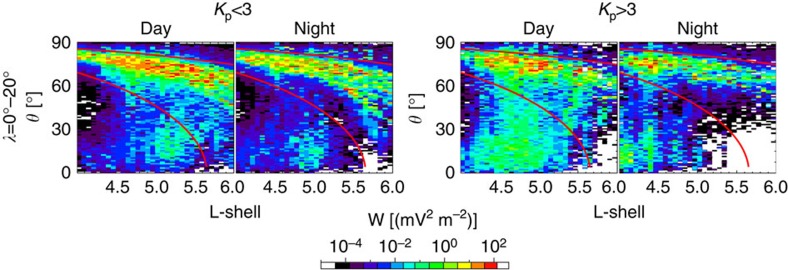
Distribution of the energy of resonant whistler waves in the radiation belts.The distribution of the wave energy density Θ2 of resonant waves (in mV2 m−2) is displayed in the (L,θ) space. The most effective resonant wave–particle interaction corresponds to a condition tan α tan θ≈1 (where α is the particle pitch angle) for electron energy <2 MeV (ref. 31). This condition has been used to plot Θ2 in this figure. Data are shown for one range of magnetic latitude |λ|∈[0°,20°], for day and night sectors, and for low (Kp<3) and high (Kp>3) geomagnetic activity. Red curves show the position of Gendrin θg and resonance cone θr angles. Both angles are calculated with the mean frequency of spacecraft observations, making use of precise plasma density measurements from IMAGE39. In the present figure, the wave refractive index has been limited to <100 in agreement with rough but conservative upper bounds due to Landau damping by average levels of hot electrons19. Three frequency channels have been taken into account: 2,244.9, 2,828.4 and 3,563.6 Hz, covering almost the full range from 2 to 4 kHz. Each channel is used in the corresponding L-shell range to measure only waves in whistler-mode frequency range.